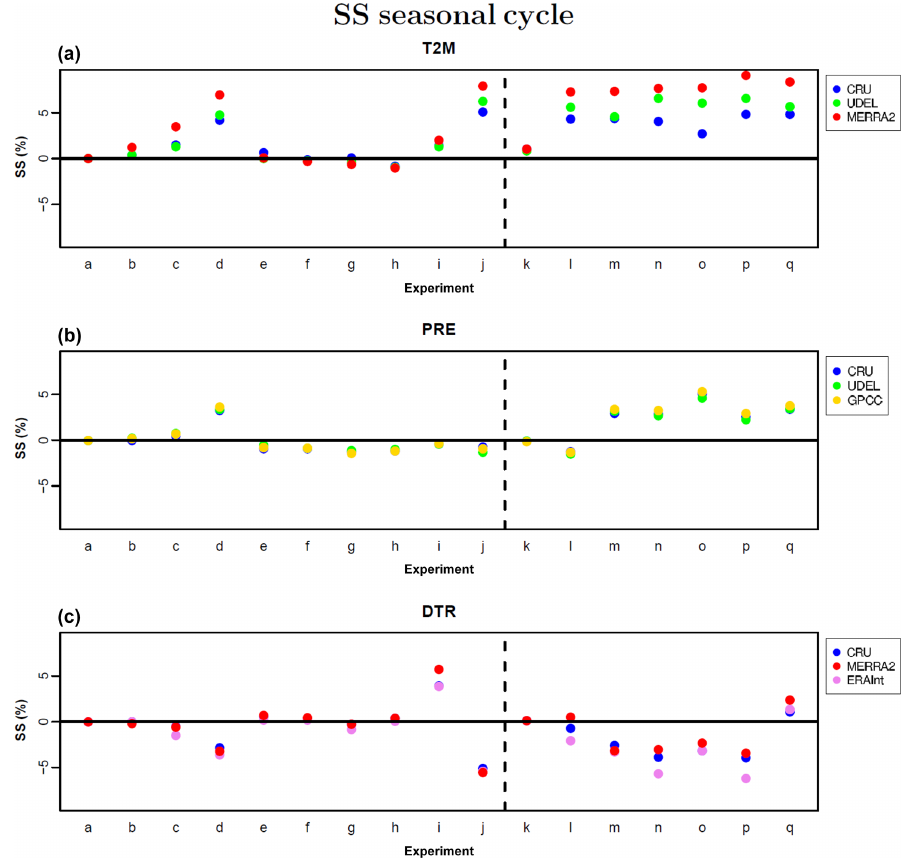
Figure 7. Skill score (SS) derived from the MAE calculated over the monthly climatological values of the seasonal cycle of different COSMO-CLM simulations and observational data sets. From top to bottom, the SS for near-surface temperature (T2M), precipitation (PRE) and diurnal temperature range (DTR) is respectively displayed. The dotted vertical black line divides the simulations with the same configu- ration of the reference simulation plus a single change in the model setup (left) and those obtained through the combinations of the previous ones (right). Positive (negative) values indicate better (worse) performance of the considered simulations compared to the reference